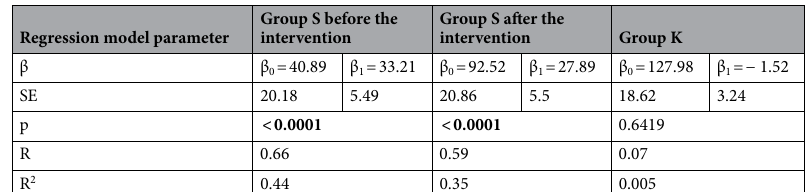
Table 9. The linear regression model (y = β 1 x + β 0 ) of the relationship between leptin (x) and VEGF A (y) serum levels. R: correlation coefficient; R 2 : R squared; SE: standard error. Significant values are given in bold.